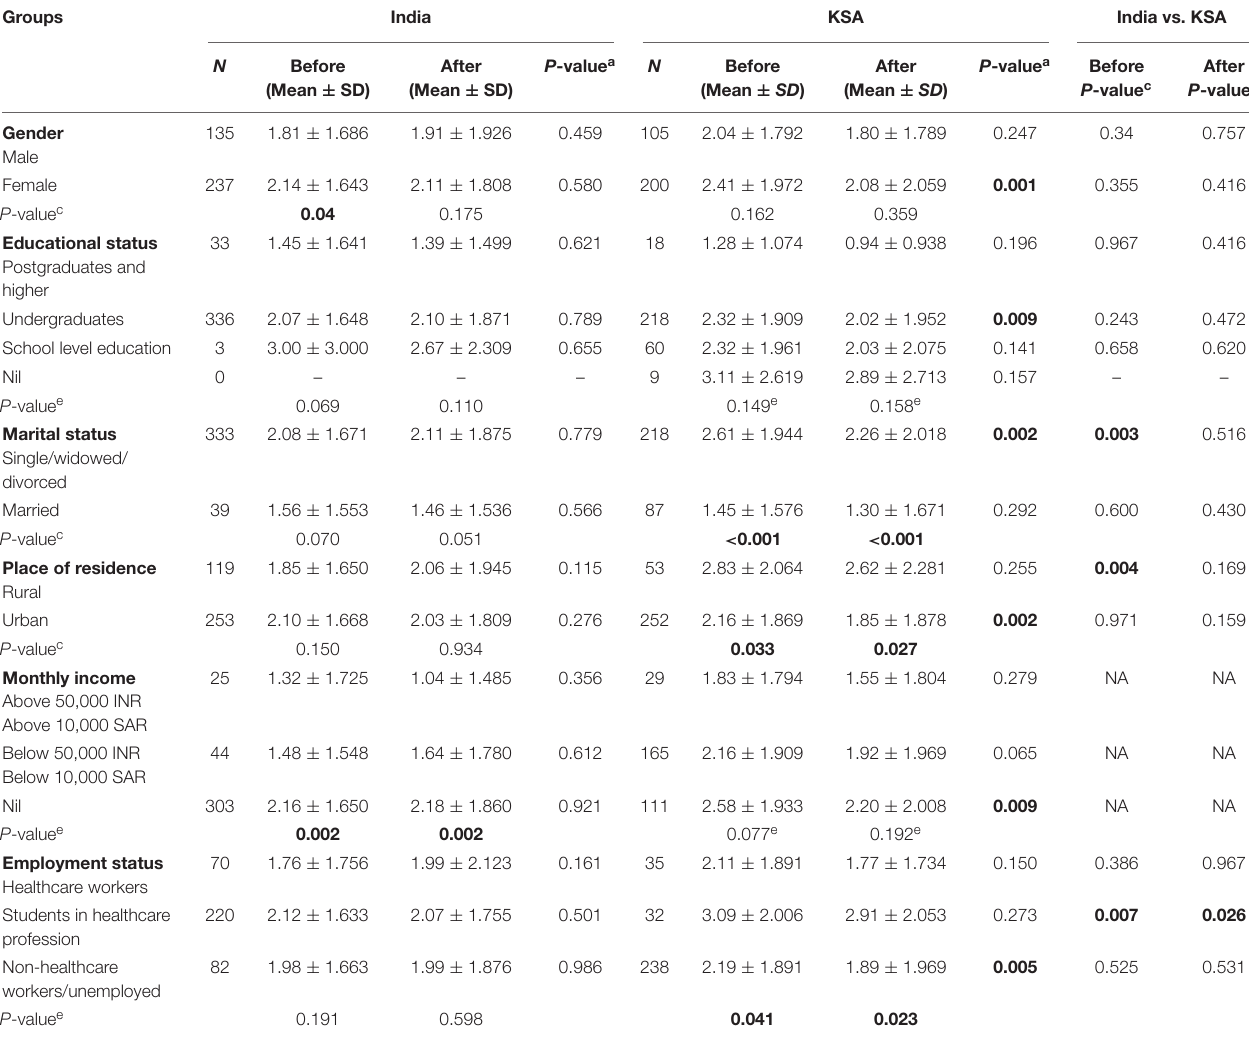
TABLE 2 | Comparison of depression symptoms stratified by sociodemographic variables before and after the advent of COVID-19 vaccines.